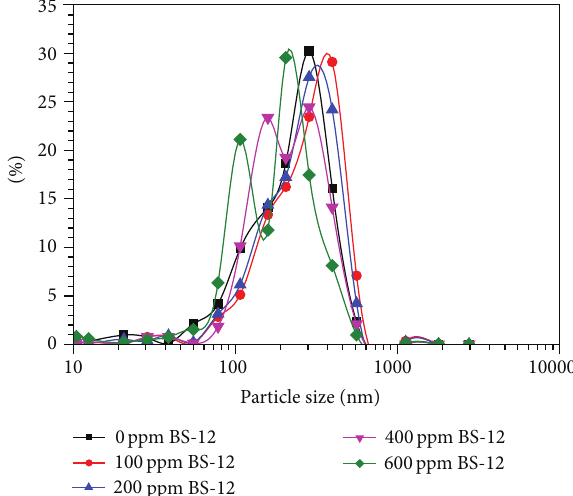
Figure 9: Particle size distributions of HAPAM with different BS-12 concentrations.